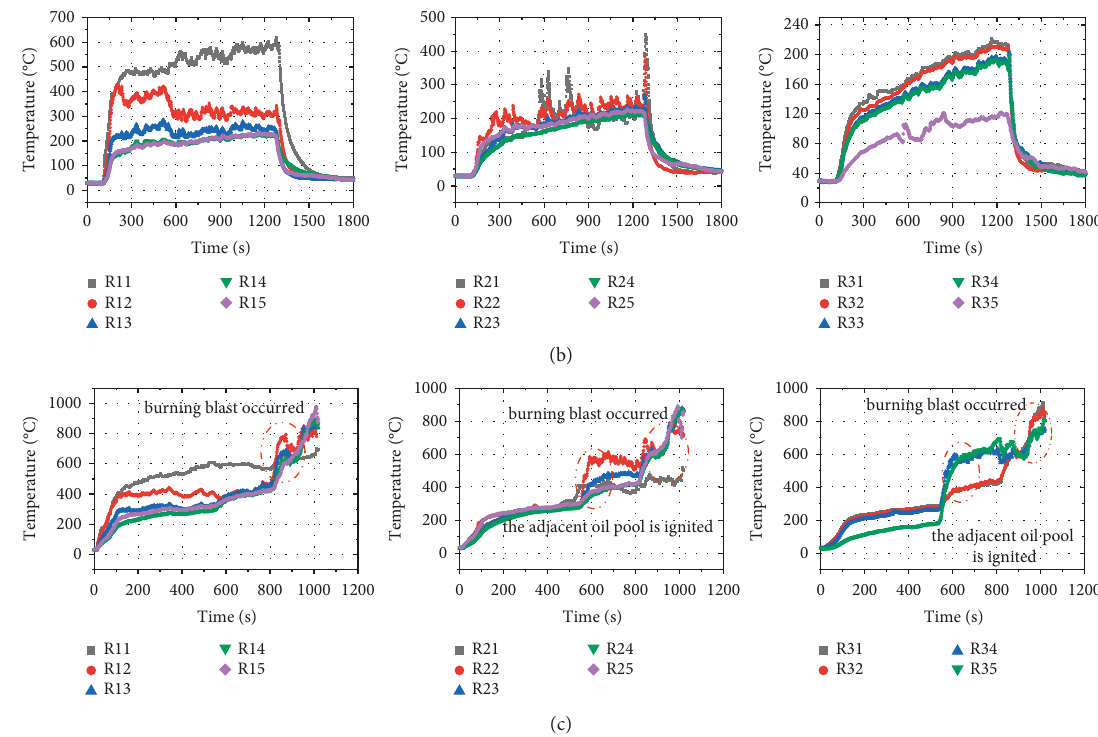
Figure 11: Temperature of each measuring point in the chamber of different conditions. (a) D � 15cm. (b) D � 20 cm. (c) D � 30cm.